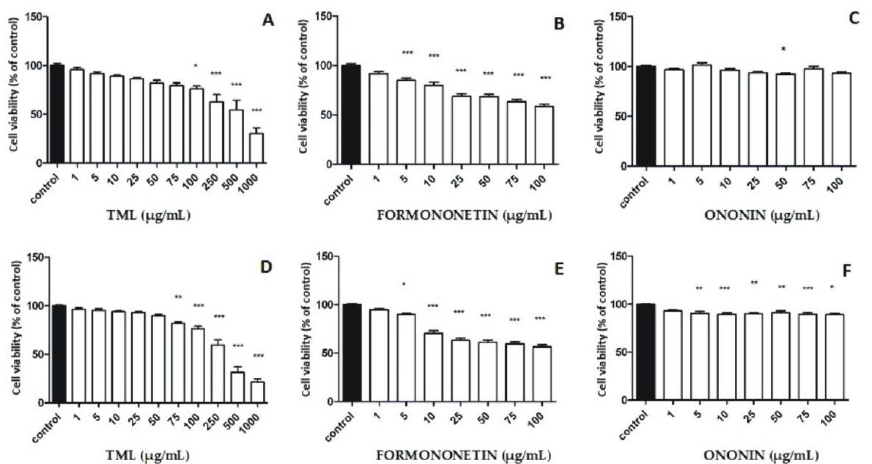
Figure 5. Effect of isoflavone reference substances and TML on the viability of MDA-MB-231 human breast cancer cells after 24 h ( A – C ) and 48 h ( D – F ) incubation; results expressed as percentage of relative viability of treated cells compared to control. Values in graphs shown as mean ( n = 3) ± SD. Statistical differences * p < 0.05, ** p < 0.01, *** p < 0.001 for control versus cell lines incubated